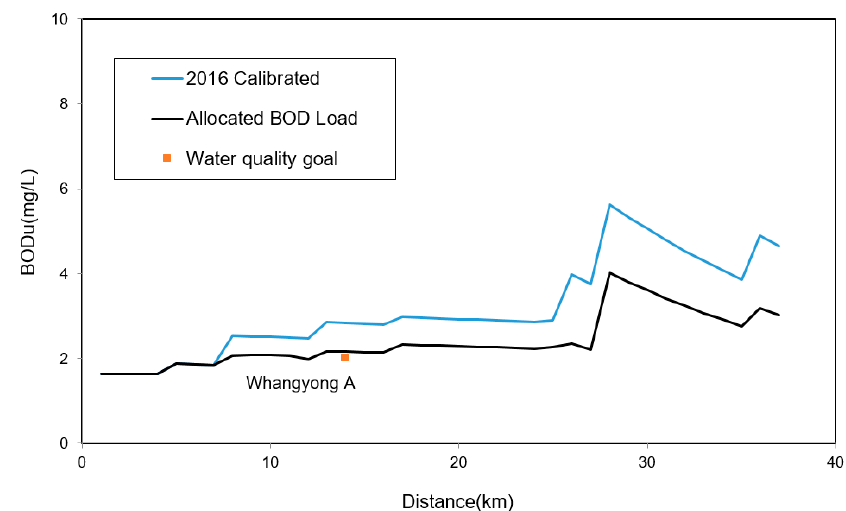
Figure 7. Water quality distribution in the Whangyonggang River after WLA application according to the fuzzy model. The allocated BOD load is the water quality distribution in the Whangyonggang River calculated from the fuzzy WLA model.